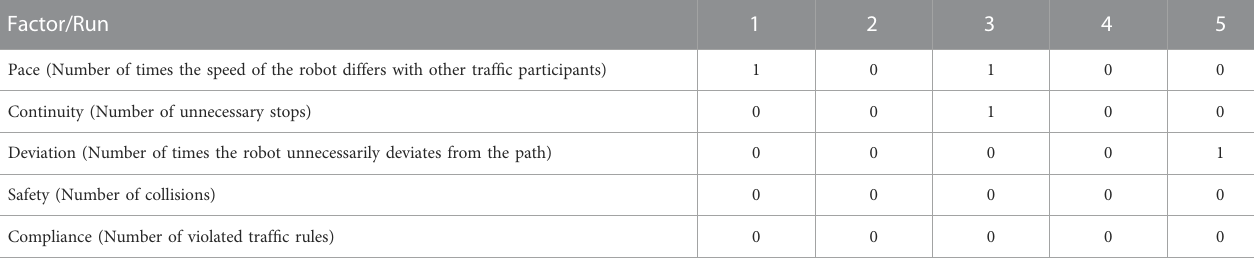
TABLE 4 Example of performance measurement setting Basis after 5 runs.